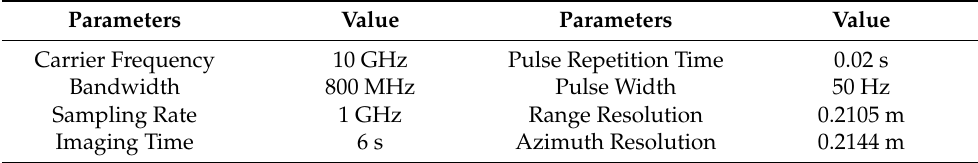
Figure 5. Simulation conditions: ( a ) scattering points model; and ( b ) Bi − ISAR simulation scenario.